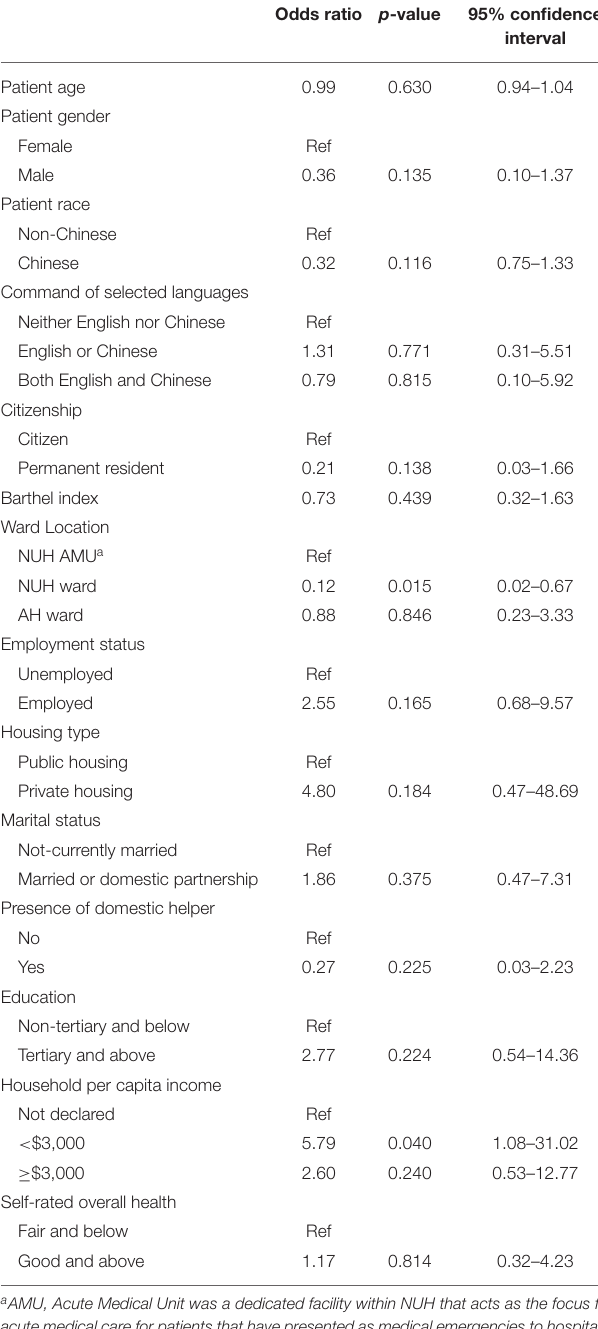
TABLE 2 | Summary of survey findings. Survey findings